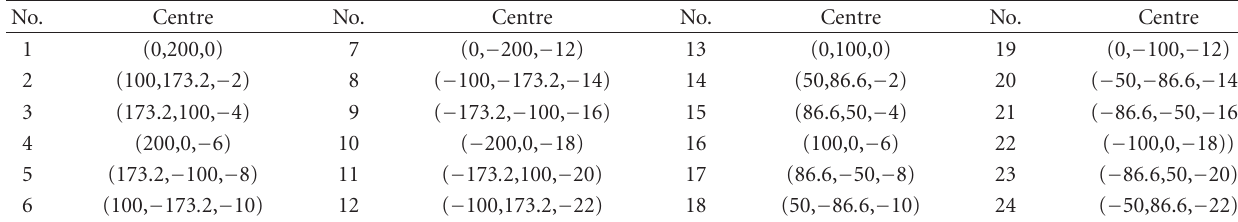
Table 1: Parameters of the clock phantom (mm).